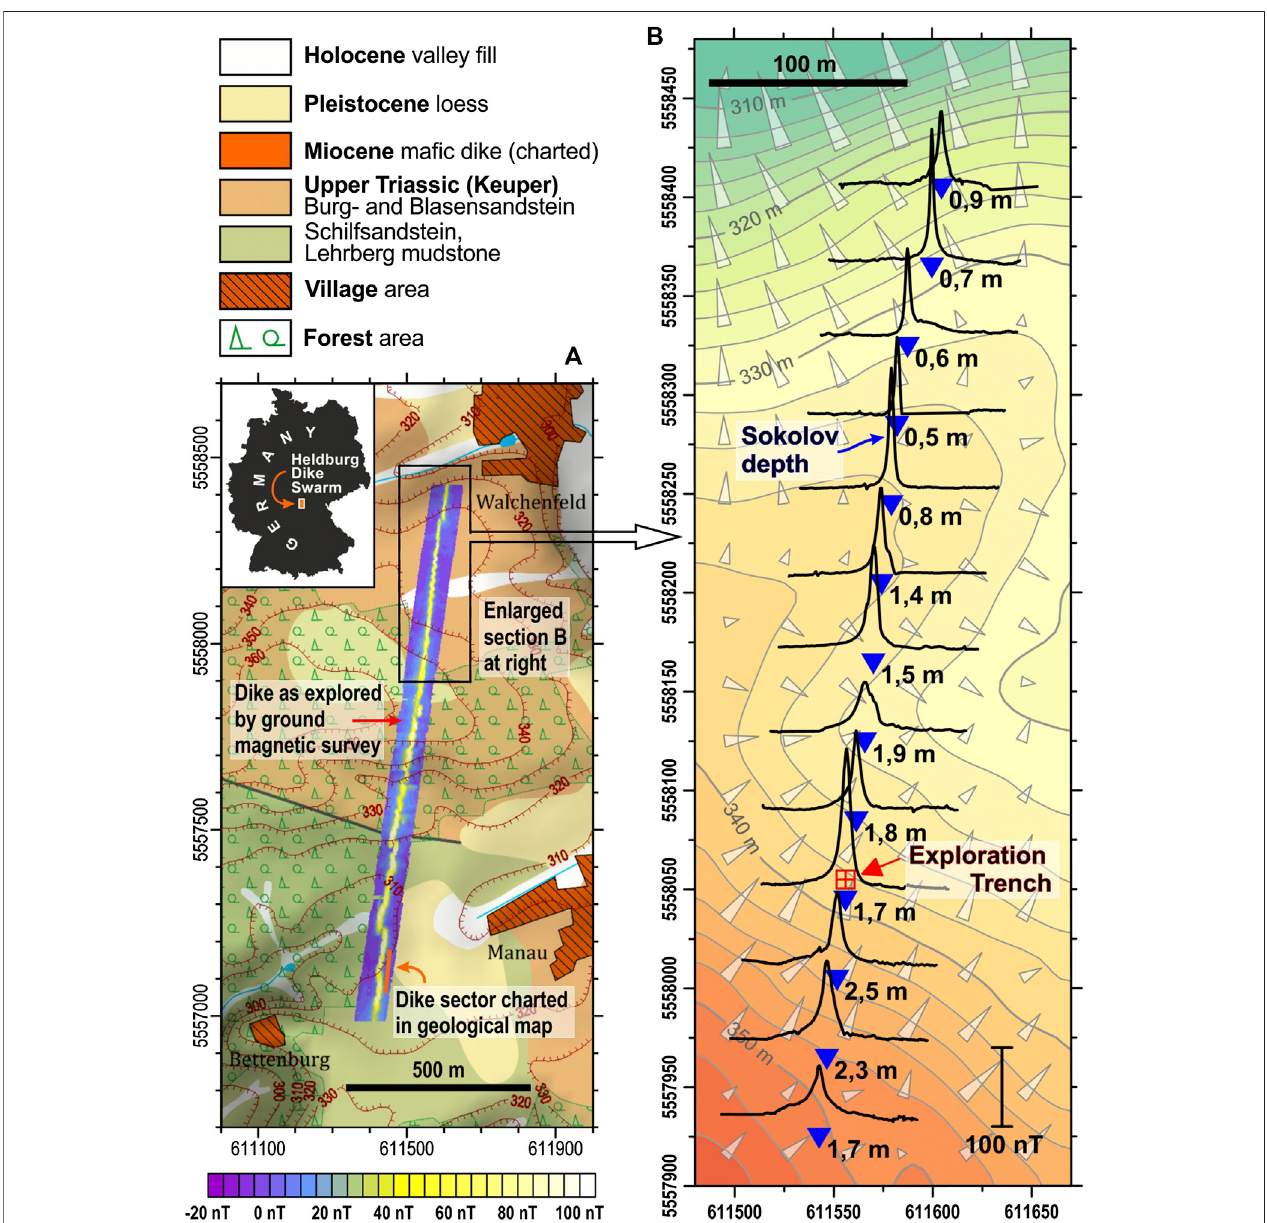
FIGURE1|(A) Inset:The HeldburgDike Swarm (HDS)region islocatedin themid-German Upper Triassic “ Keuper ” formations.Previously charted sector (orange line) and newly explored complete course (magnetic anomaly map in blue/yellow) of a weathered mid-Miocene basalt dike near the villages of Manau and Walchenfeld (Hassberge, NorthernBavaria).Theshown geologicalmapisredrawnfrom Schröder(1976) andgeoreferencedtoUTMcoordinates(WGS84sector32N). (B) Northern dikesectiondelineatedby13precisiongroundmagneticW-Epro fi les.Notethevaryingamplitudesandshouldersoftheanomaly.Bluetrianglesandnumbersmark dike center positions and Sokolov depth estimates. The red squaresymbolizesthe position oftheexploration trench. Topographiccontourlines are based on own GPS elevation data; gray arrows mark slope gradients.